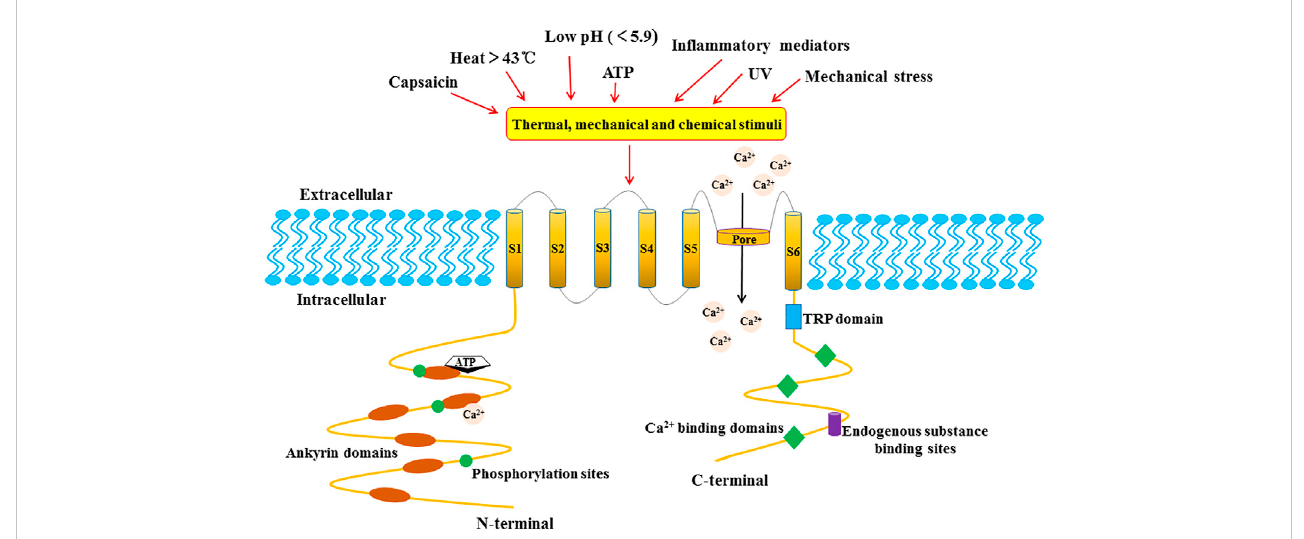
FIGURE 1 The structure of the TRPV1 channel subunit. TRPV1 is a homo-tetramer, and each subunit is composed of six-transmembrane domains (S1-S6) with a pore-forming hydrophobic group. The long N-terminal contains several phosphorylation sites and six ankyrin repeat domains. The C-terminal bears a TRP domain, multiple calmudulain binding domains and endogenous substance binding